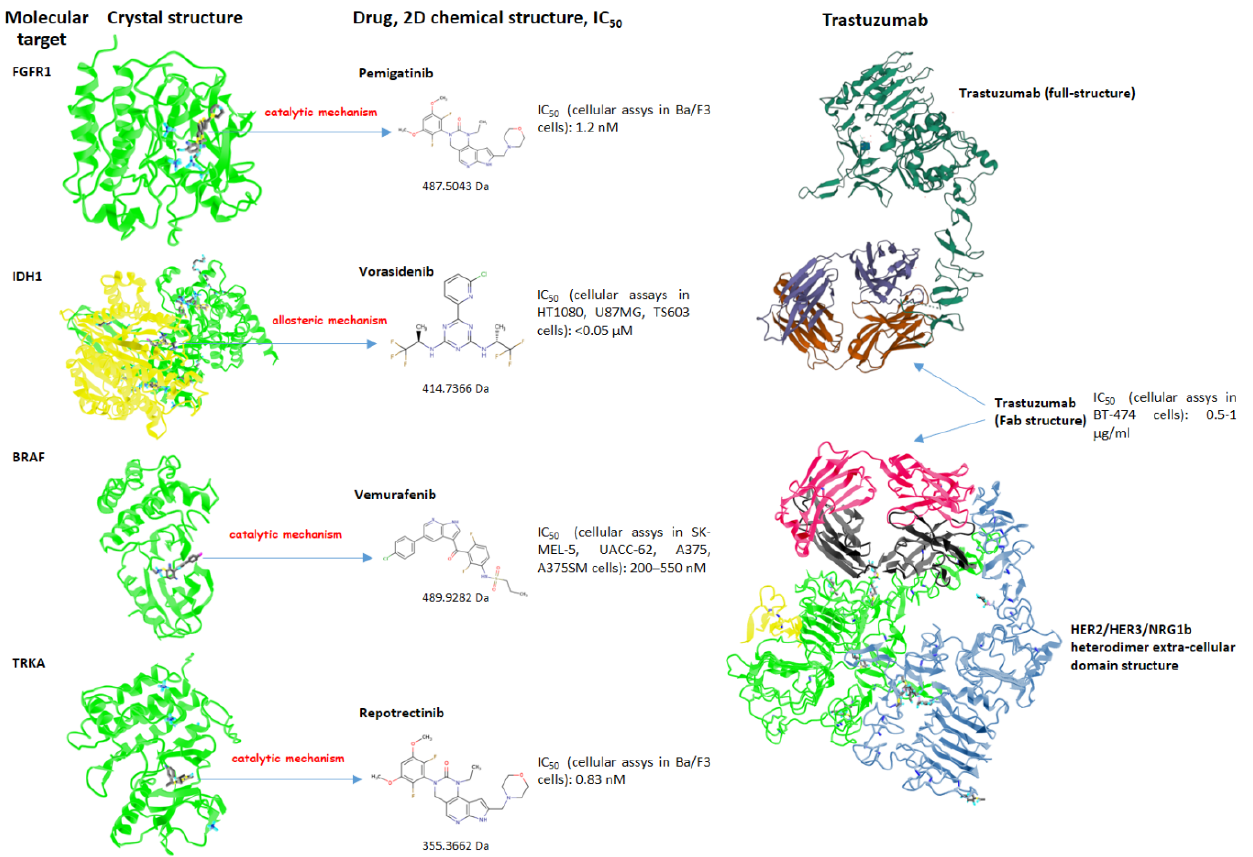
Figure 5. Schematic representation of the molecular targets and their crystal structures, inhibitory small molecules with their 2D chemical structures, molecular weights, and IC 50 (for each IC 50, the cellular model used to establish it is reported). For exploring the single amino acids involved in the structural interactions between the chemical compounds and the molecular target in a 3D naviga- tion perspective, please visit the online research tool of the NCBI (National Center for Biotechnology Information) [87]. When the crystal structure of the protein in the complex with the molecule re- ported in the article was not available, we reported the structure bounded to a chemical compound belonging to the same functional class (vorasidenib for ivosidenib and repotrectinib for larotrectinib, both interacting with the same functional regions of IDH1 and TRKA, respectively). The inhibitory effect through the “allosteric mechanism” signifies that the molecule inhibits the target by binding to an allosteric site that is distant from the catalytic/active site of the kinase. In this case, a confor- mational change is induced, preventing access to the enzymatic pocket. 9. Conclusions and Perspectives CCA incidence is increasing and, unfortunately, its prognosis remains very poor. The reasons are large genetic heterogeneity (from a molecular point of view) and scarce chem- otherapy responsiveness (from a clinical point of view). These characteristics render the CCA a perfect model to study and apply innovative and molecularly oriented drugs. A new class of drugs is now emerging, and its application is necessarily preceded by the genetic profiling of CCA towards a “precision oncology” (i.e., next-generation sequenc- ing). Every patient will deserve a “from bench to bad” approach and commitment. In this expanding context, future clinical research paradigms (first-line biologic therapies, re- peated genetic assessments with liquid biopsy, associations, biologics re-challenges, etc.) must be pursued that revolutionize our dogmatic approaches to sequential treatments, molecular testing, and response monitoring. Author Contributions: Conceptualization, M.C., M.S., L.L., and A.O.; methodology, V.G., F.P., and V.C.; software, O.G.; validation, G.N. and A.O.; resources, A.O.; data curation, A.O., M.S., and M.C.;